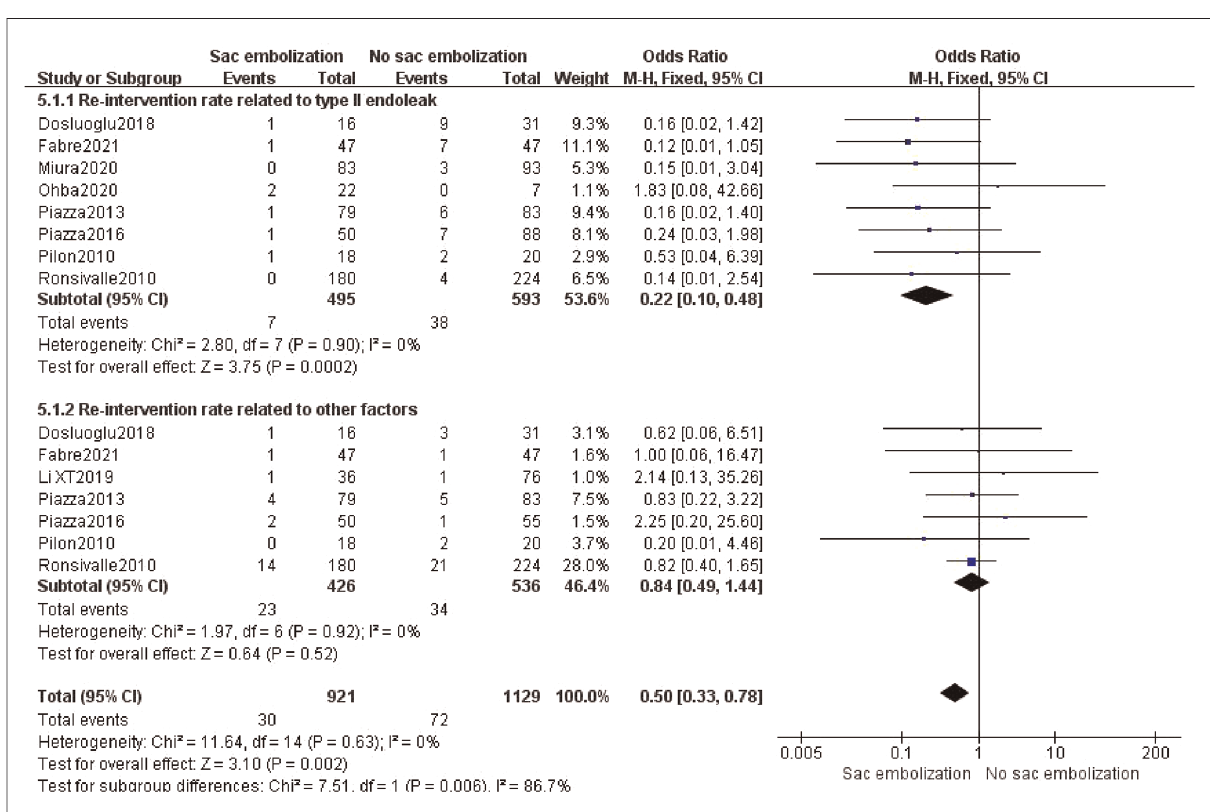
FIGURE 7 The rate of re-intervention in the embolization group compare with the non- embolization